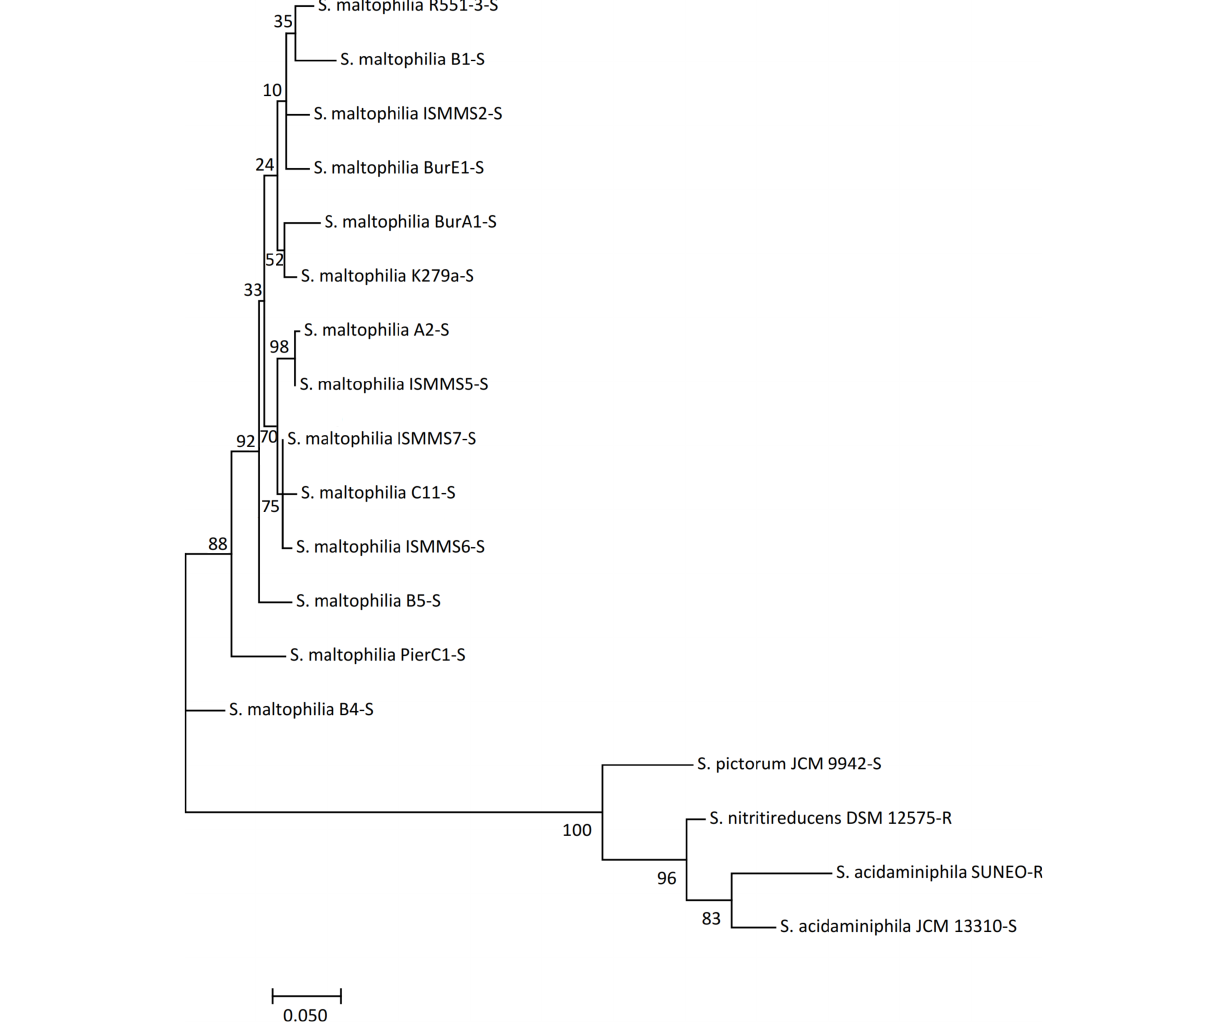
FIGURE 5 | Phylogenetic tree of the amino acid sequences of dihydropteroate synthase homologs from Stenotrophomonas strains. Evolutionary history was inferred by using the maximum likelihood method. The bootstrap consensus tree inferred from 1,000 replicates is taken to represent the evolutionary history of the taxa analyzed. R: resistant to TMP-SMX. S: susceptible to